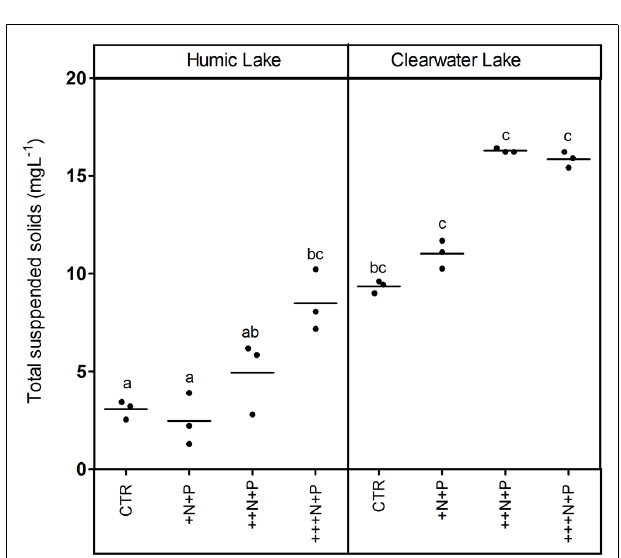
FIGURE 3 |Total suspended solids (TSS) after different N addition for humic and clear waters. Legend as described in Figure 1 .